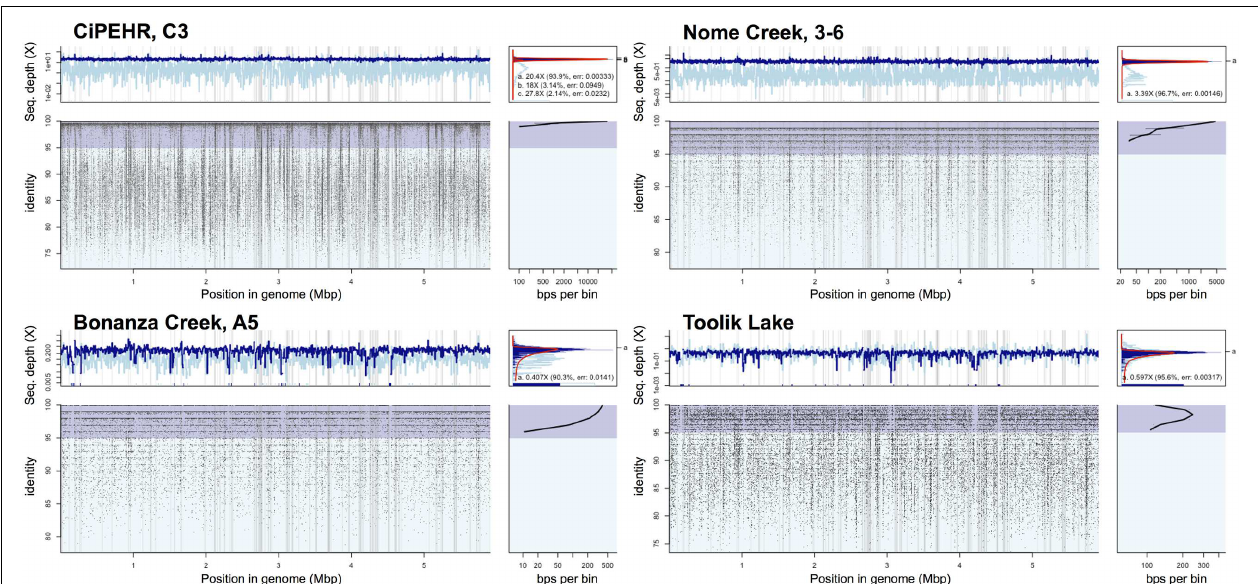
FIGURE 5 | Read recruitment plot of population bin 07 at four distinct tundra locations. Diagrams expressing coverage of population bin 07 (assembled from CiPEHR, AK metagenomes) in metagenomic datasets from four distinct geographic locations, each separated by 100–530 km distances. All short reads from select sample metagenomes were searched against all contigs of the bin in a megablast search. The position histogram (top left of each) displays the average coverage of each base position, determined by a 1,000 bp window. The dark blue histogram represents the coverage at each base position determined from reads matching ≥ 70 bp in length and ≥ 95% nucleotide identity, while the light blue represents the coverage determined from reads matching ≥ 70 bp in length and < 95% nucleotide identity. An even coverage across the entire contig from matching reads that are high identity ( > 95%) is indicative of a high quality contig from a single population. The recruitment plot (bottom left of each) shows where individual metagenomic reads matched to the population bin and the identity (%) of the match. The ID histogram (bottom right) displays the total number of short read-derived base-positions at given percent identities. Note that in all cases shown, a sequence-discrete population represented by reads showing high nucleotide identity to the reference population genome sequence (typically > 95% nucleotide identity) and even coverage across the length of the reference sequence is